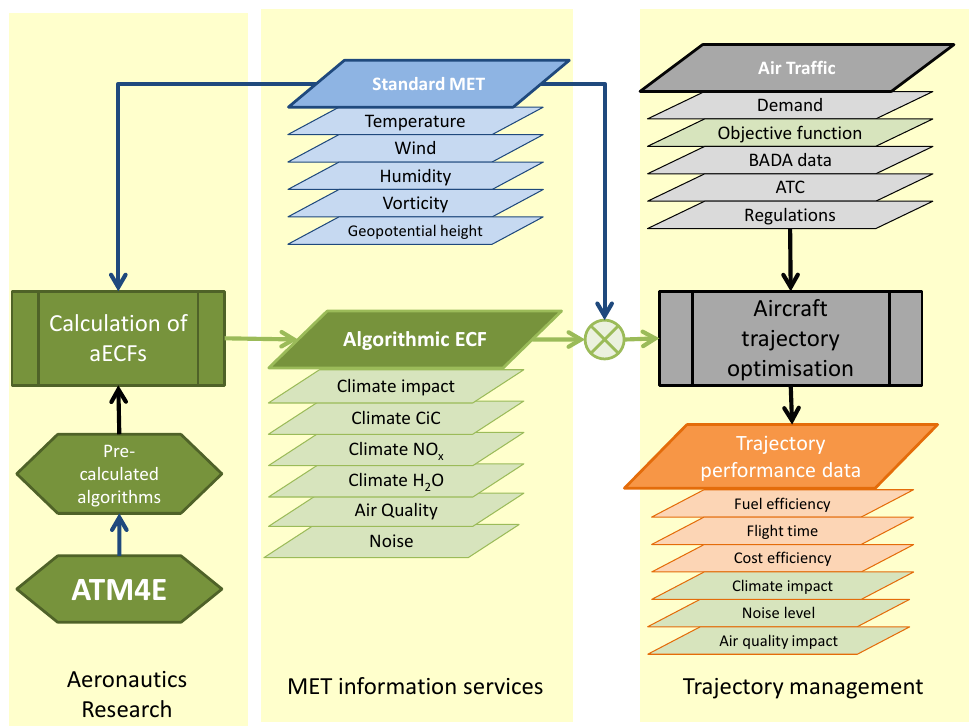
Figure 2. Flowchart of Environmental Assessment of aircraft trajectory management using ATM4E algorithmic environmental change functions (aECF) concept, with elements newly introduced by ATM4E highlighted in